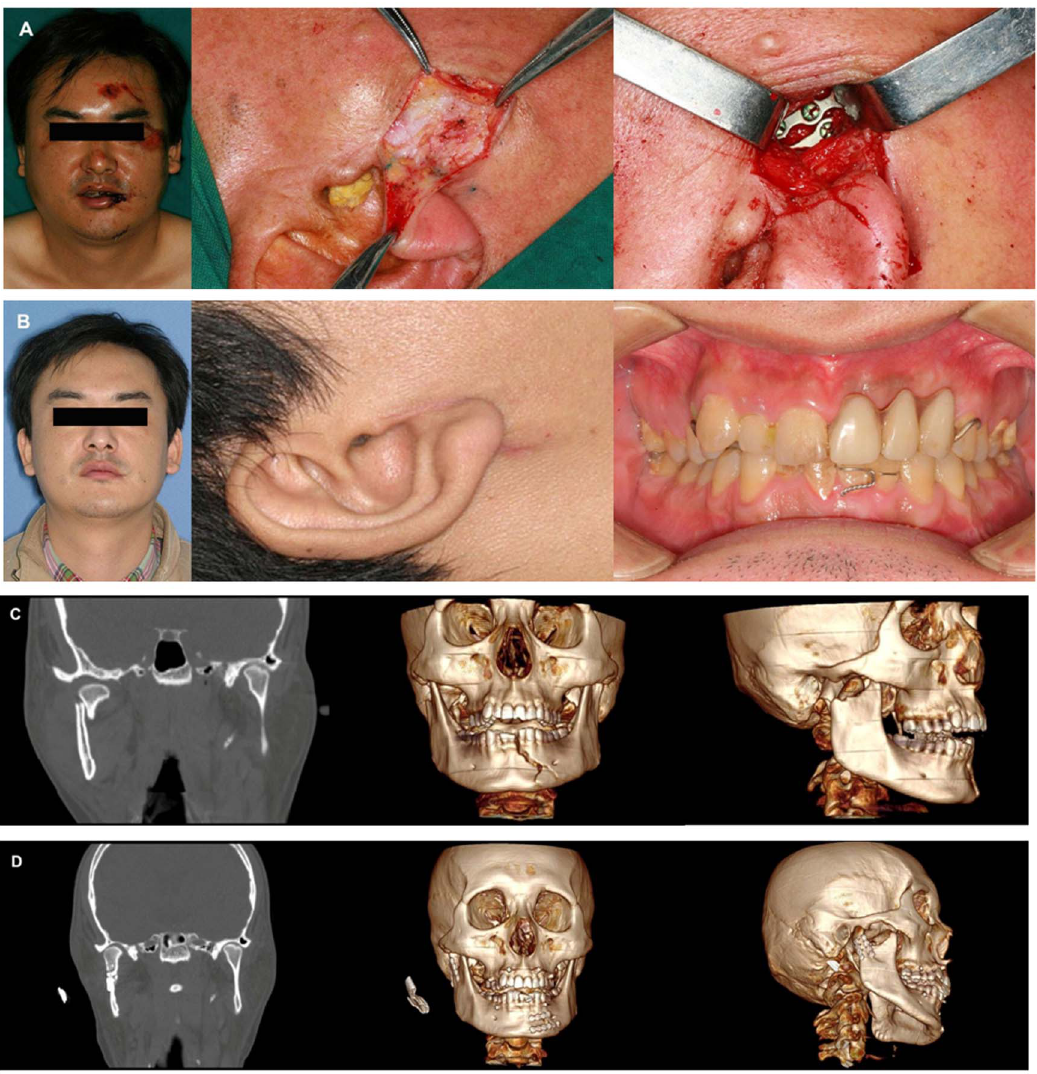
Figure 2. Photographs show a 33-year old male patient undergoing open reduction and rigid internal fixation of right condylar fracture 5 days after trauma. A: Pre-operative facial appearance and rigid internal fixation; B: Post-operative facial appearance and occlusion; C: Pre-operative CT scan and 3D reconstruction images; D: PT scan and 3D reconstruction images taken at follow-up.